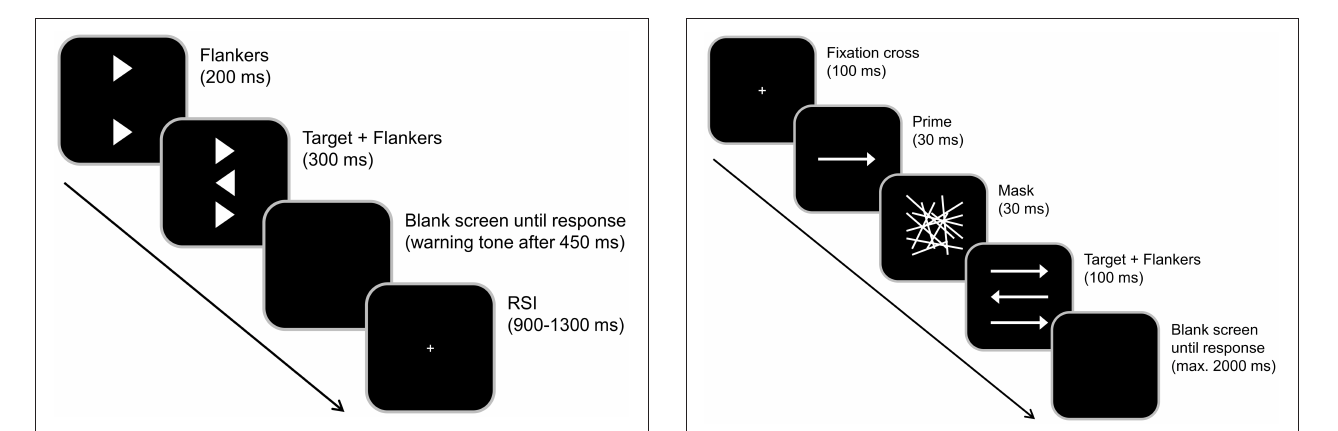
FIGURE 3 | Illustration of the combined conflict paradigm adapted from Boy et al. (2010), as used in our previous acute intoxication study (Stock et al., 2017). Each trial began with a 100ms presentation of a white fixation cross in the center of a black screen. This was followed by a 30ms presentation of the prime (a central white arrow) and a 30ms central presentation of a mask. The target and flankers were simultaneously presented for 100ms in the center of the screen. Each trial ended either with the first given response indicating the pointing direction of the target stimulus (the arrow in the middle) or 2,000ms after the onset of the target (in case no responses were given). Compatible and incompatible primes as well as congruent and incongruent flankers were presented equally often and in a random order. The response-stimulus or inter-trial interval randomly varied between 1,000 and